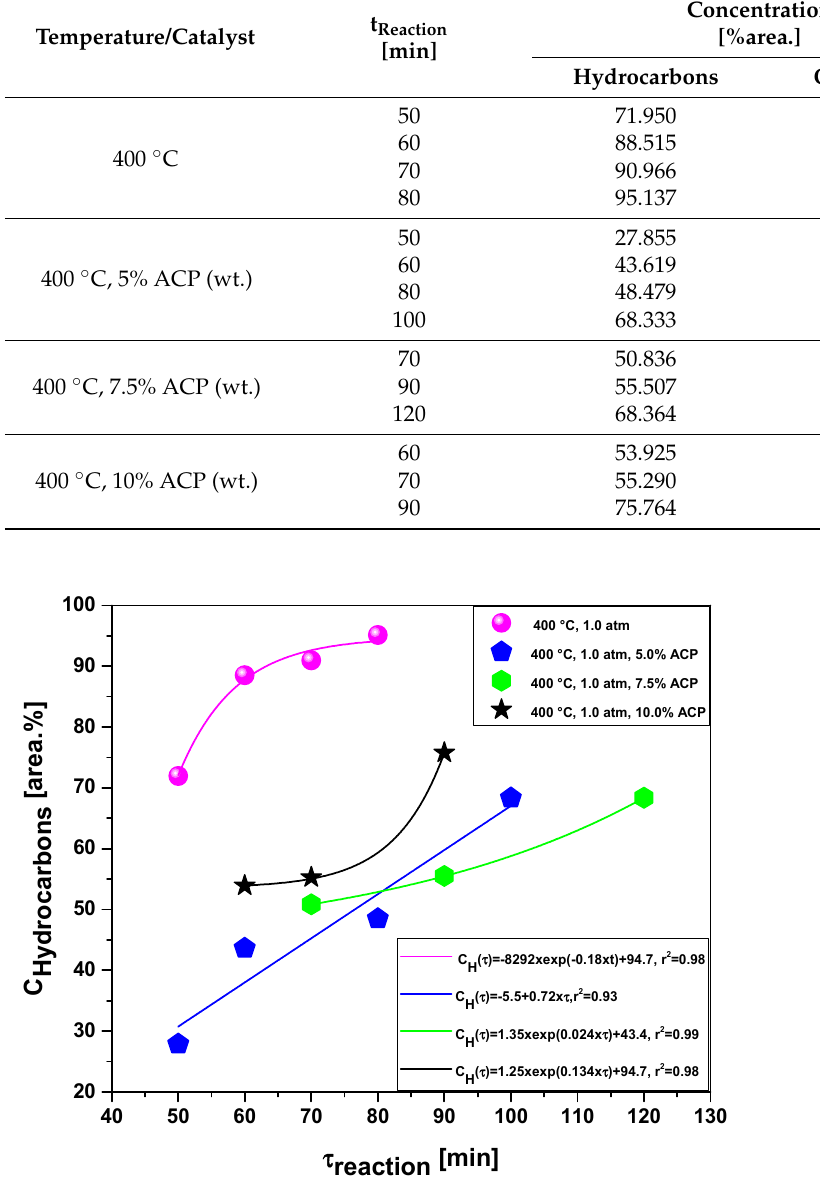
Temperature/Catalyst